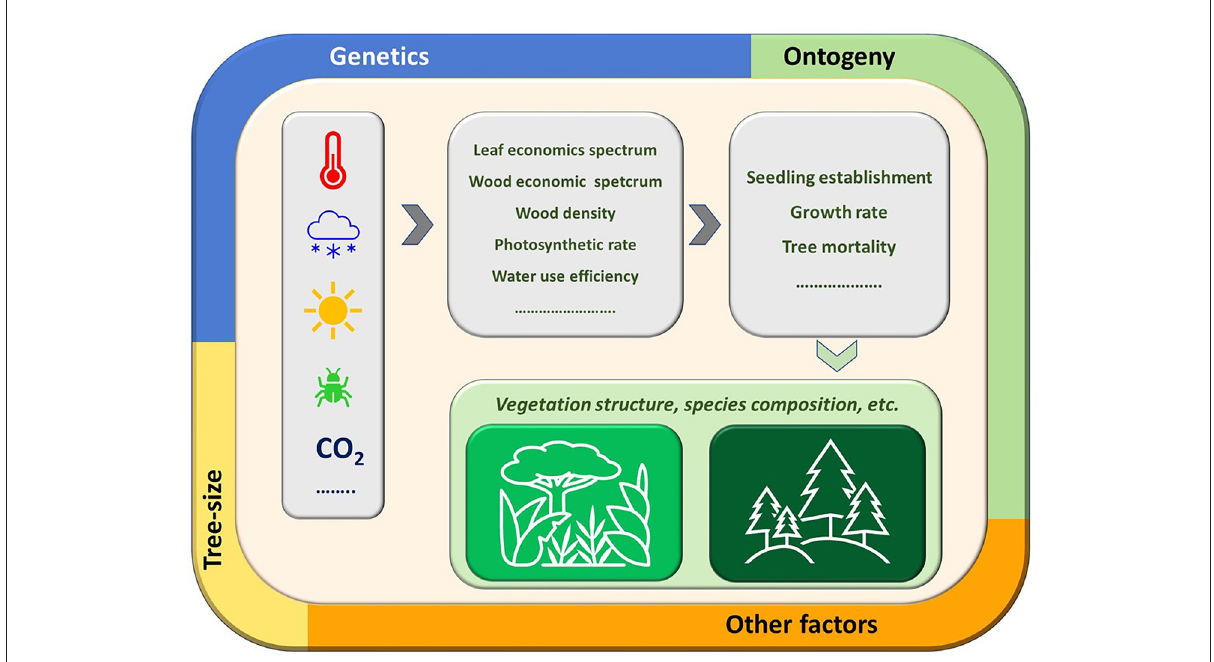
FIGURE1 Schematic representation of the impact of climate-driven environmental changes on plant traits and thus on vital rates which in turn determine the composition of forest communities. Such impacts can be different on the various biomes also due to the interaction with other drivers including genetics, tree-size, and ontogeny whose weight is variable and needs further research at multiscale